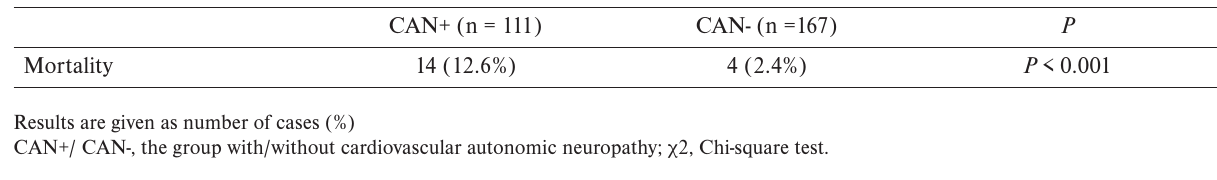
Table 4. Predictors of